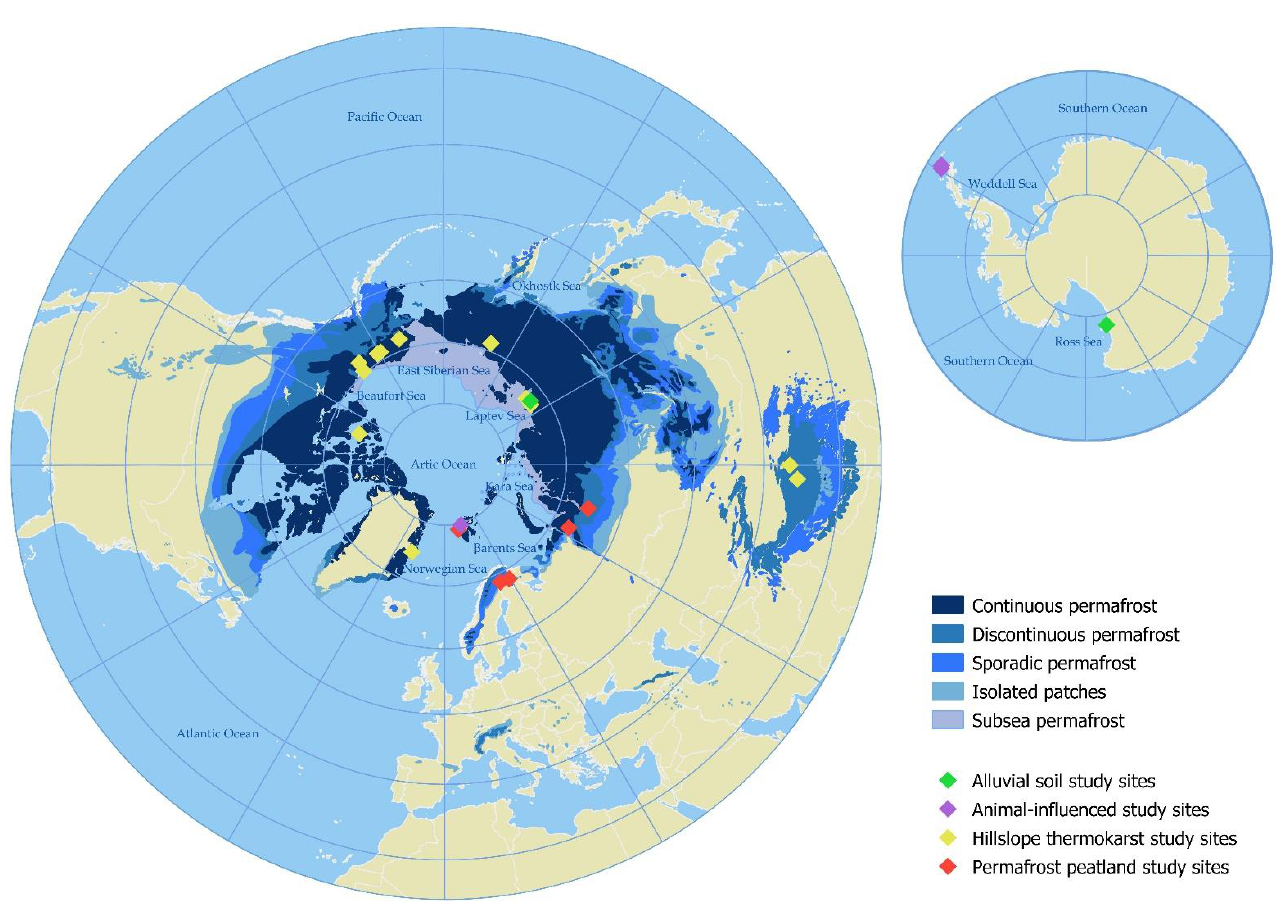
Figure 1. Map of study sites of N hotspots in the Arctic and the Antarctic in the continuous and discontinuous permafrost zone summarized in this review. Study sites of permafrost peatlands are marked in red, the sites of hillslope thermokarst in yellow, sites of alluvial soils in green and animal-influenced sites in purple. Maps modified after Brown et al. [31].